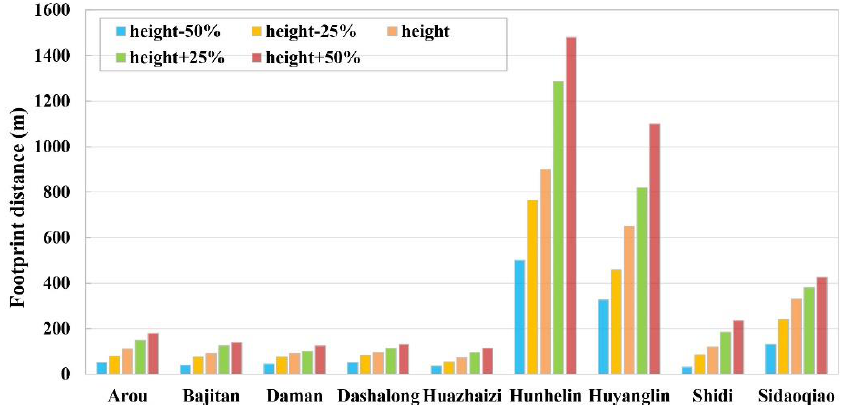
Figure 8. Changes of field GPP footprint with the changes of measurement height.